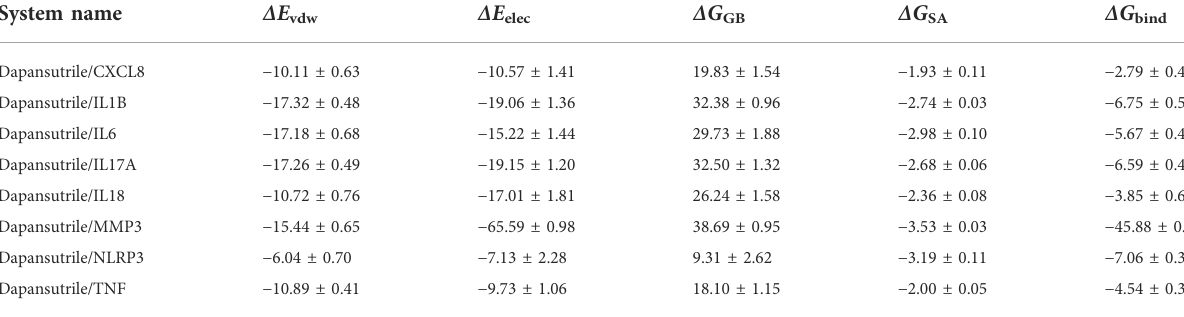
TABLE 2 Binding free energies and energy components predicted by MM/GBSA